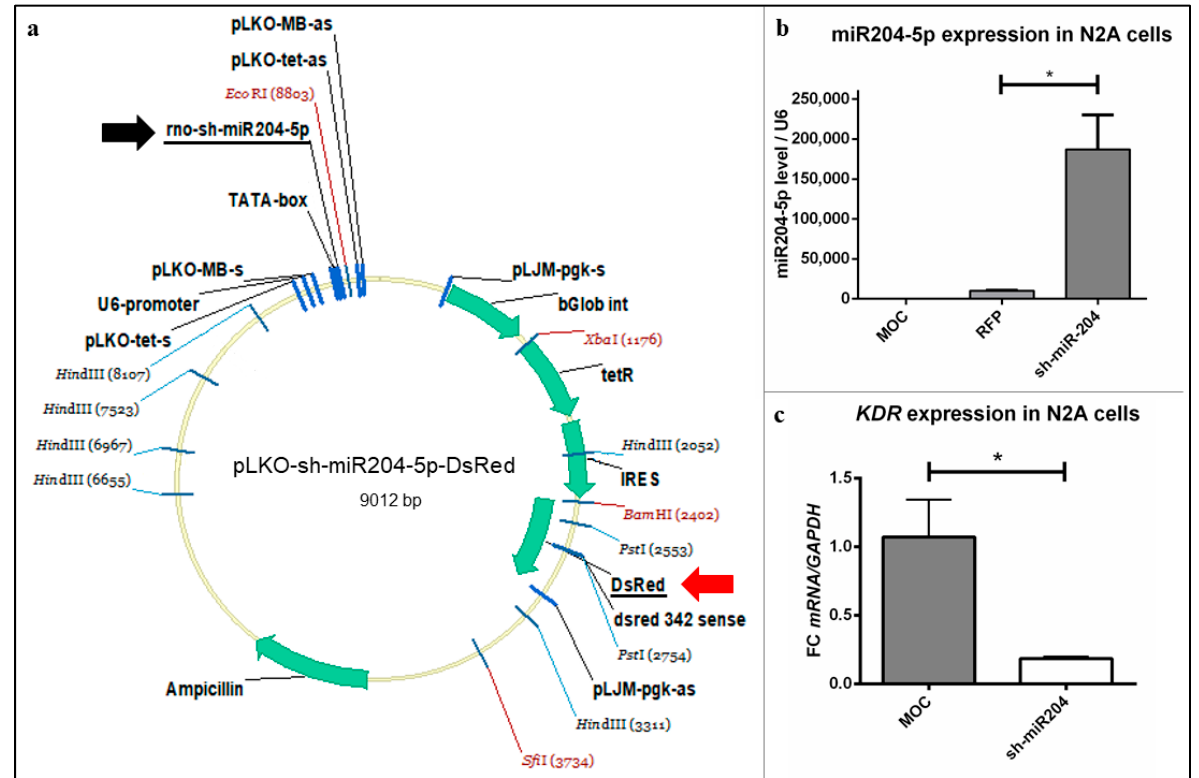
Figure 4. Vector map and testing of pLKO-miR204-5p-DsRed. ( a ) Vector used for microinjection contained the sh-miR204-5p sequence (black arrow), to investigate its effect on VEGF-triggered growth of PC, as well as DsRed (red arrow) to detect a successful injection of the plasmid into the PC. ( b , c ) N2A cells were transfected and processed for qRT-PCR. ( b ) For relative quantification of miR204-5p overexpression and ( c ) KDR expression level, the 2 (– ΔΔ Ct) method was accomplished using ( b ) U6 and ( c ) GAPDH as housekeeping genes. Controls: MOC—pure transfection reagent; red fluorescent protein (RFP)—LifeAct Tag RFP. Data are provided as means ± SEM. Significant differences are indicated by * p < 0.05; n = 3.